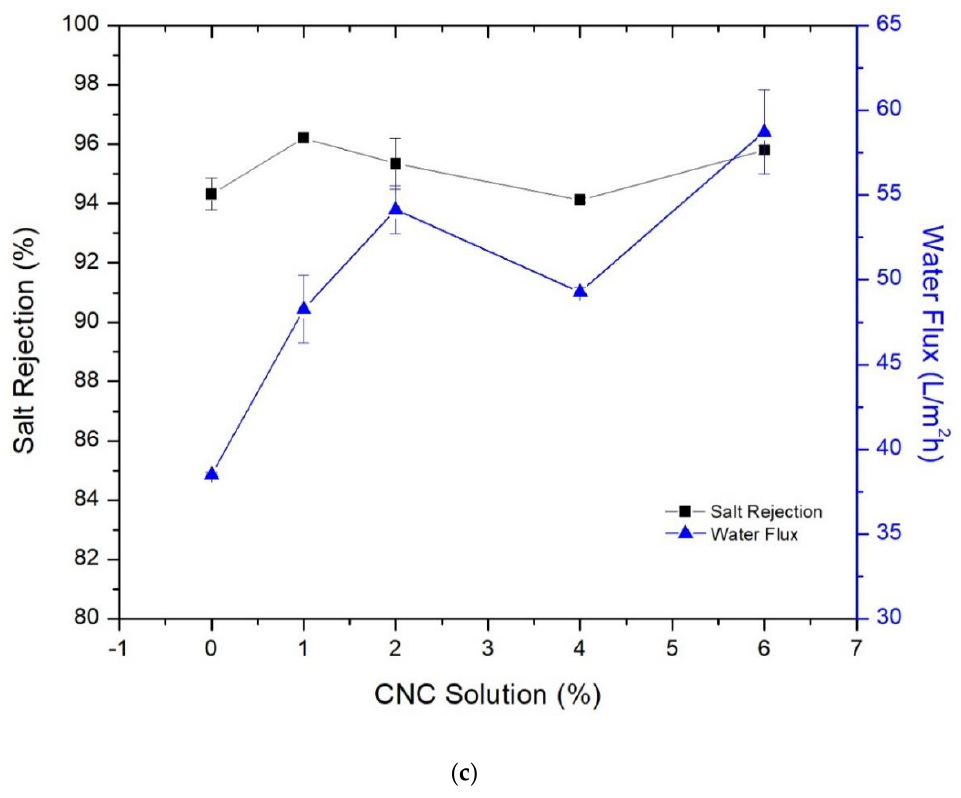
Figure 7. Membranes performance after adding ( a ) CMCs powder to the TFN membrane, ( b ) CNCs gel to the TFN membrane, and ( c ) CNCs gel to the support layer casting solution.